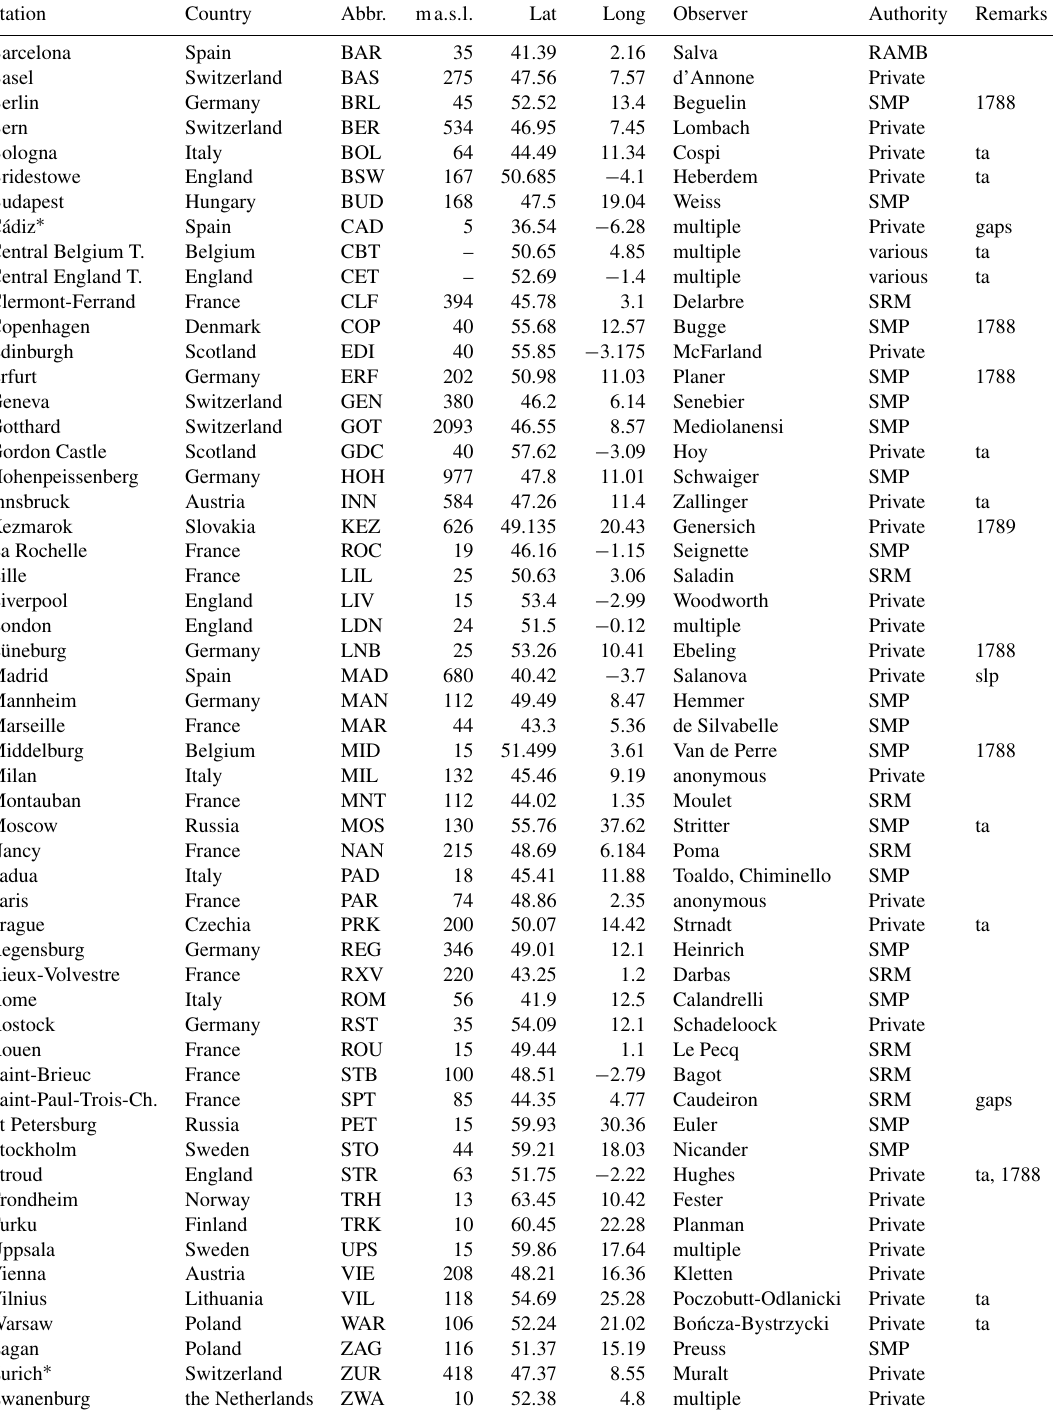
Table 1. List of stations used for the reconstruction, described by the modern country they belong to, their station code, approximate height above sea level, latitude, longitude, the name of the observer(s) if known, and the authority (private or network). Stations marked by ( ∗ ) represent series that are used in the independent validation. SMP, SRM, and RAMB respectively stand for Societas Meteorologica Palatina, Société Royale de Médécine, and Royal Academy of Medicine of Barcelona. The last column lists any remarks pertaining to a series: ta means that only temperature is used, and slp is for just sea level pressure; 1788 or 1789 means that only data for these years are available; a blank implies that both variables were used in the reconstruction across both